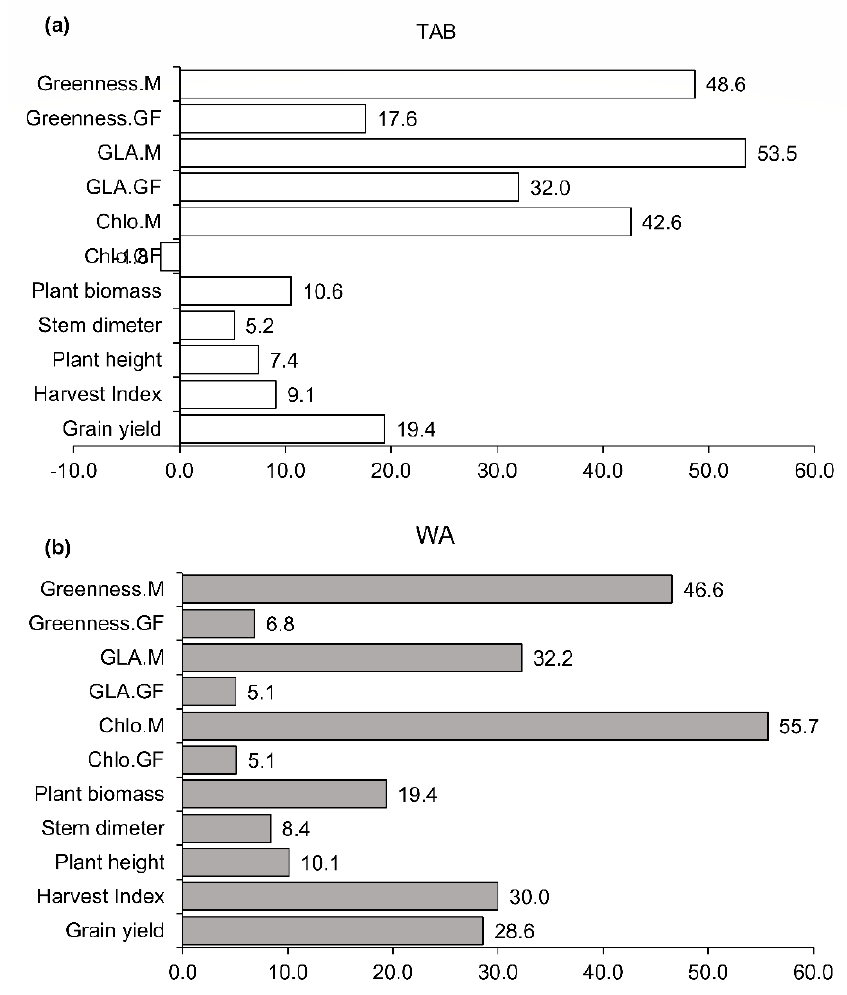
Figure 3. The reduction percentage in stay-green and grain yield related traits measured under irrigated and post-flowering drought in ( a ) 46 and ( b ) 52 stay-green introgression lines derived from crosses of B35 × Tabat (TAB) and B35 × Wad Ahmed (WA), respectively, at Faki Hashim Research Farm, Khartoum North, Sudan. Chlo and GLA denote chlorophyll content and green leaf area, respectively. GF and M denote grain filling and maturity, respectively.